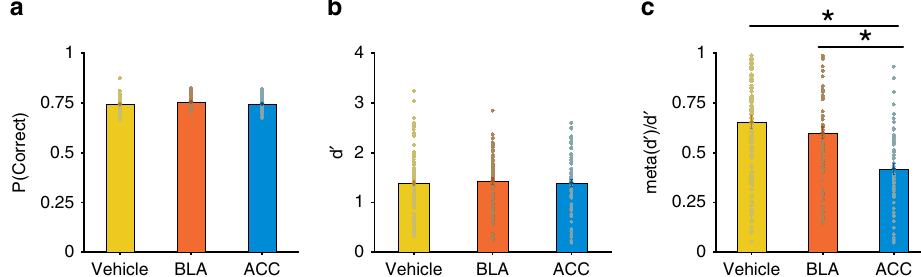
Fig. 5 Discrimination performance is intact following inhibition of either ACC or BLA, but metacognitive ef fi ciency is decreased following inhibition of ACC only. a Plotted is the probability of correct responses for the sessions following vehicle administration (yellow), sessions following BLA inhibition (orange), and sessions following inhibition of ACC (blue). Error bars show S.E.M. b Plotted is discrimination performance, d ′ in the three conditions de fi ned in panel ( a ). c Plotted is the metacognitive ef fi ciency (meta — d ′ / d ′ ) in the three conditions de fi ned in panel ( a ). (*) indicates p < 0.05 in one-way ANOVA test. Source data are provided as a Source Data fi